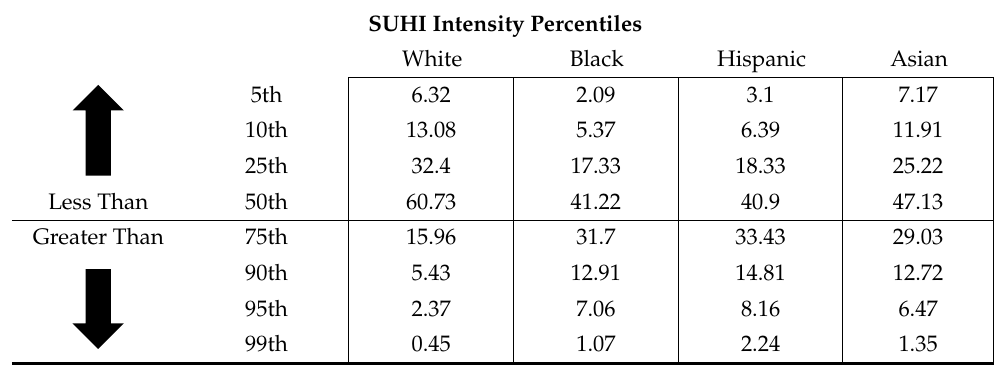
Table 3. Percentage of population (in the study) residing in percentile breakdown of SUHI intensity by census tract.